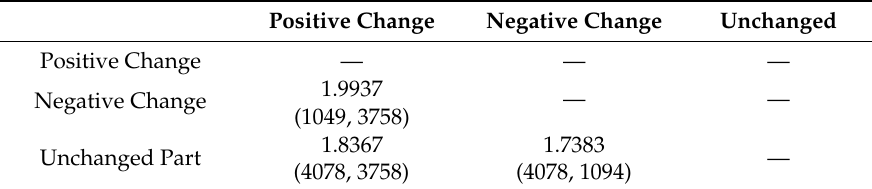
Table 3. The JM separability among two changed classes and the unchanged